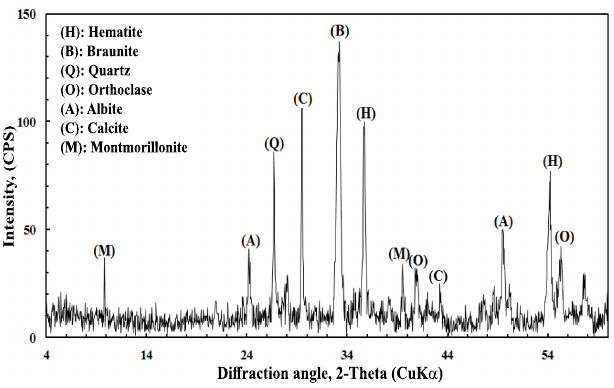
Fig. 3. XRD graph of the siliceous manganese sample.